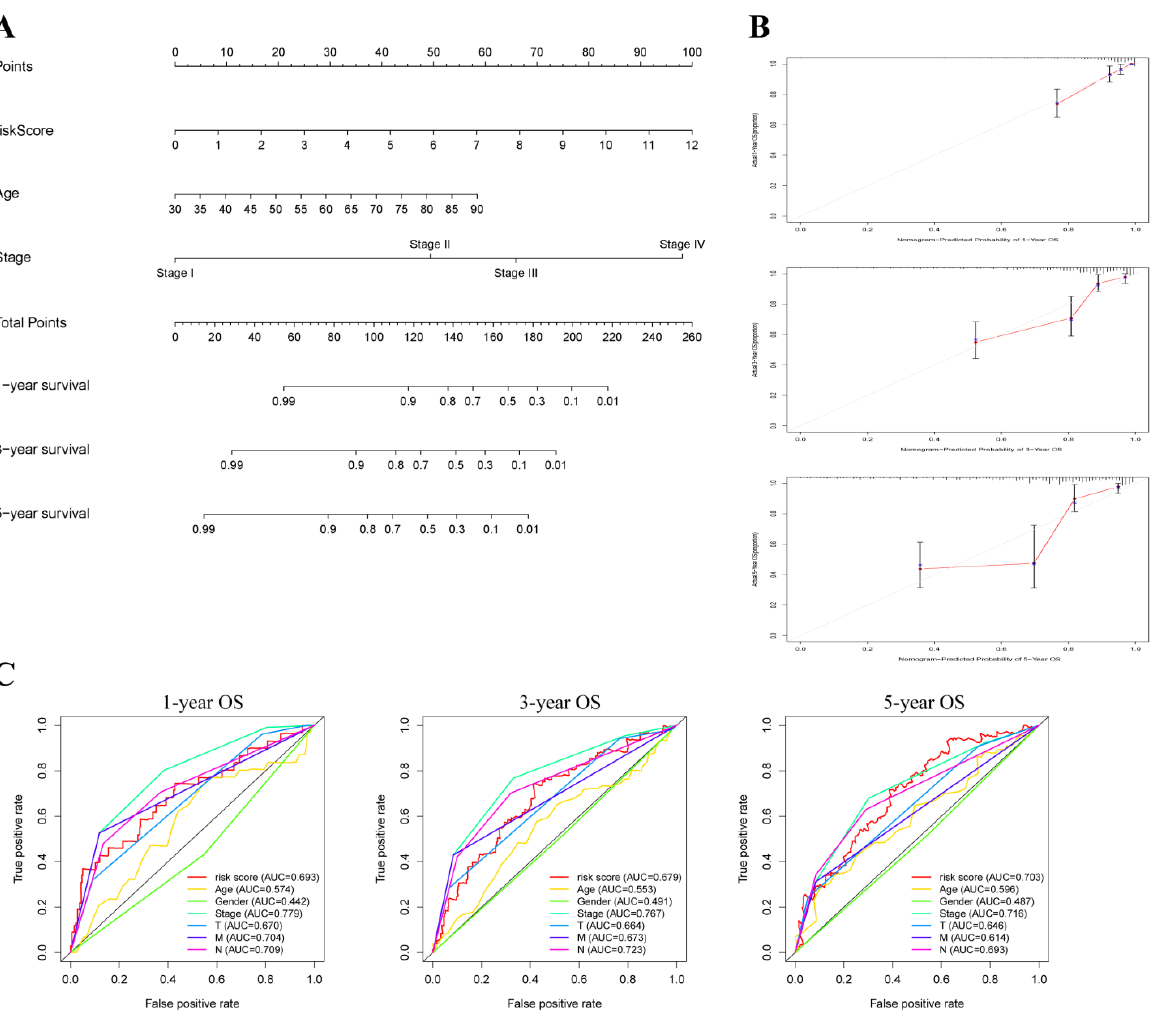
Figure 4. Construction of nomogram for predicting survival of COAD patients. ( A ) The prediction of 1-, 3-, and 5-year survival for COAD patients based on the prognostic nomogram including clinic- pathological features (age, stage, risk score). ( B ) Calibration plots of 1-, 3-, and 5-year OS revealed the consistency between nomogram-predicted survival probabilities and the actual outcome. ( C ) ROC curves of 1-, 3-, and 5-year OS indicated the prognostic accuracy of OXPHOS-related gene risk score and other clinical characteristics (age, gender, clinical stage).